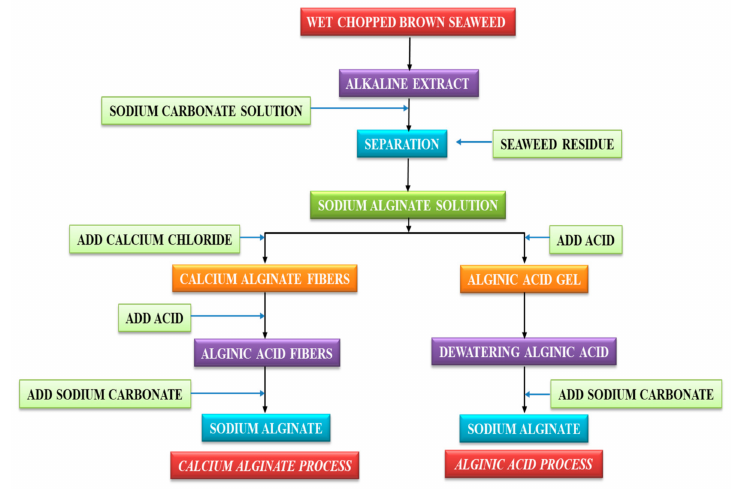
Scheme 2. Flow chart for the isolation of alginic acid and sodium